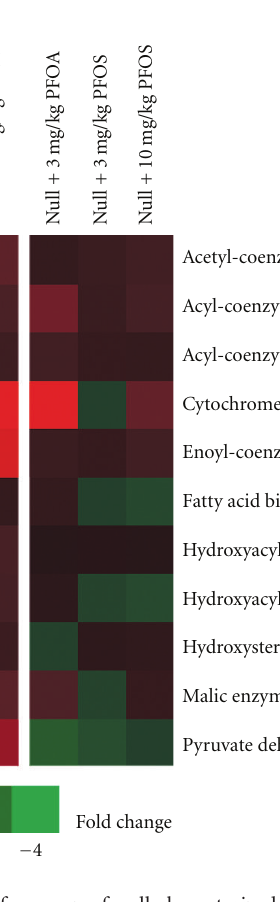
Figure 2: Expression of a group of well characterized markers of PPAR α transactivation in WT and Null mice. The response to PFOS in WT mice was less robust than that previously observed for either PFOA or Wy14,643. Red or green correspond to average up- or down- regulation,